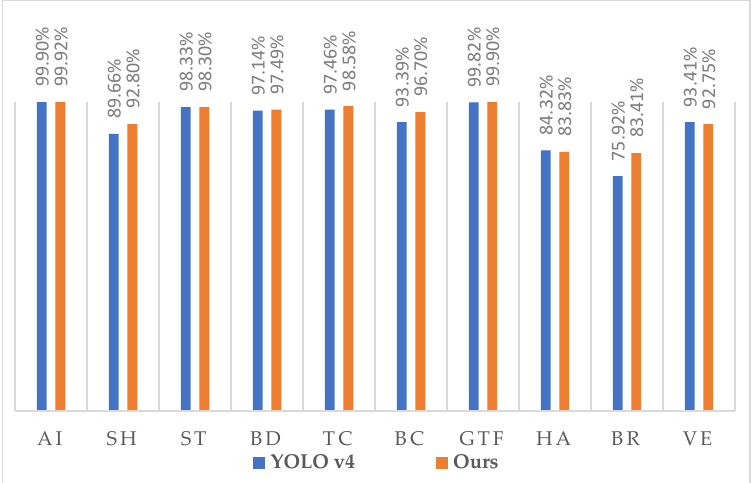
Figure 8. Comparison of the results of each category between YOLO v4 and Ours.